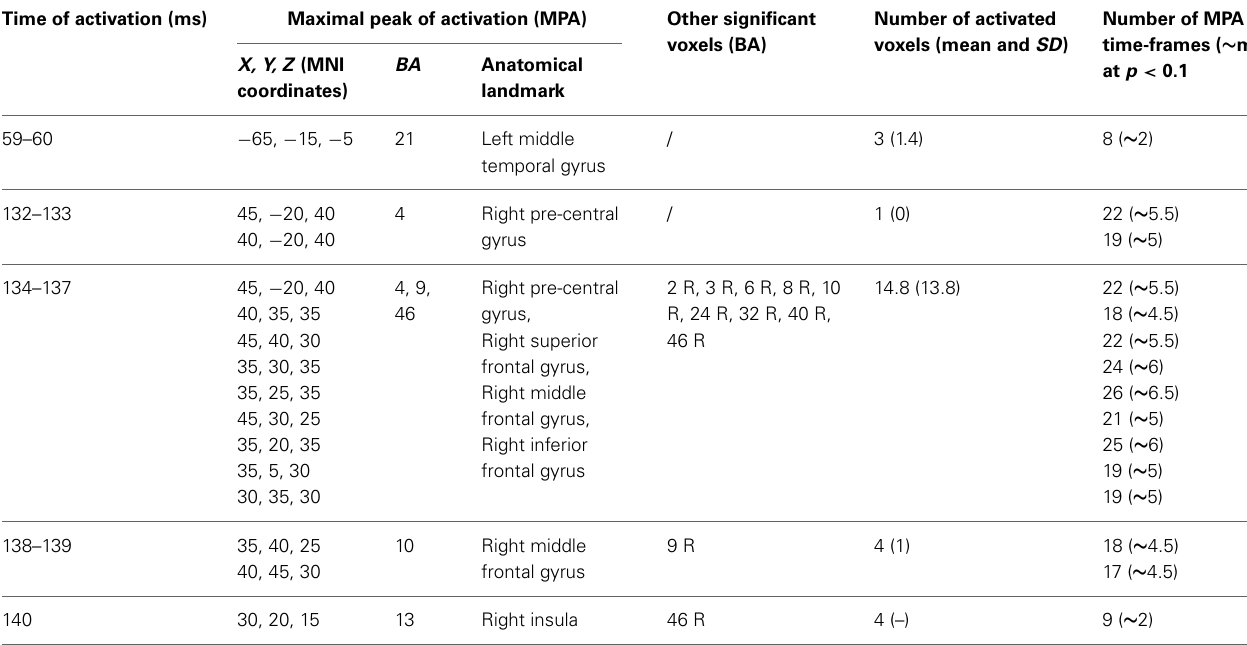
Table 1 | Results from time-frame by time-frame sLORETA analysis (t-statistic). Time of activation